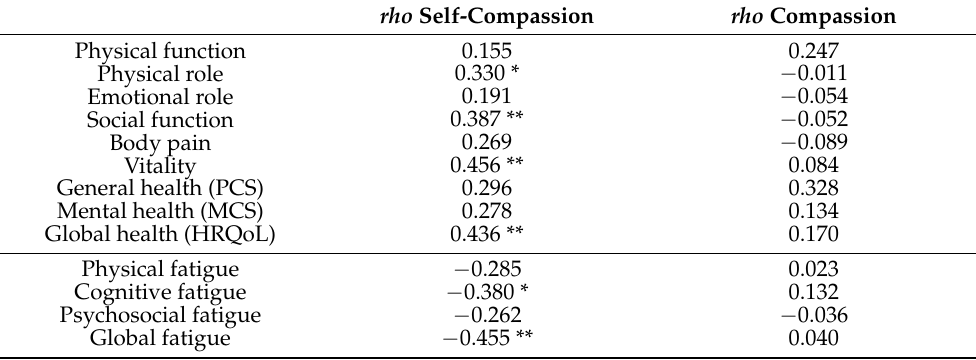
Table 4. Correlations between psychological variables of self-compassion and compassion and vari- ables of health and fatigue in a sample of people with MS and their caregivers ( rho Spearman